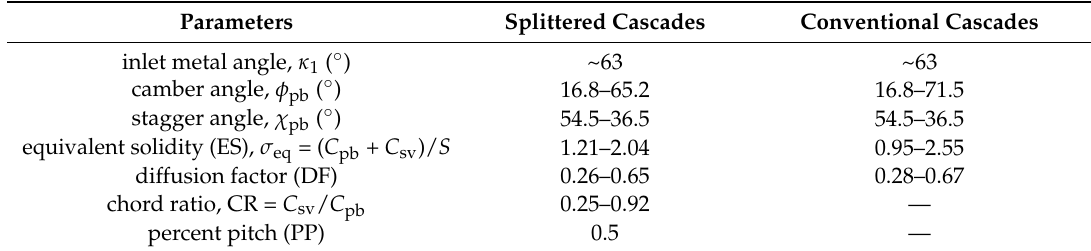
Table 1. Ranges of different parameters for the basic